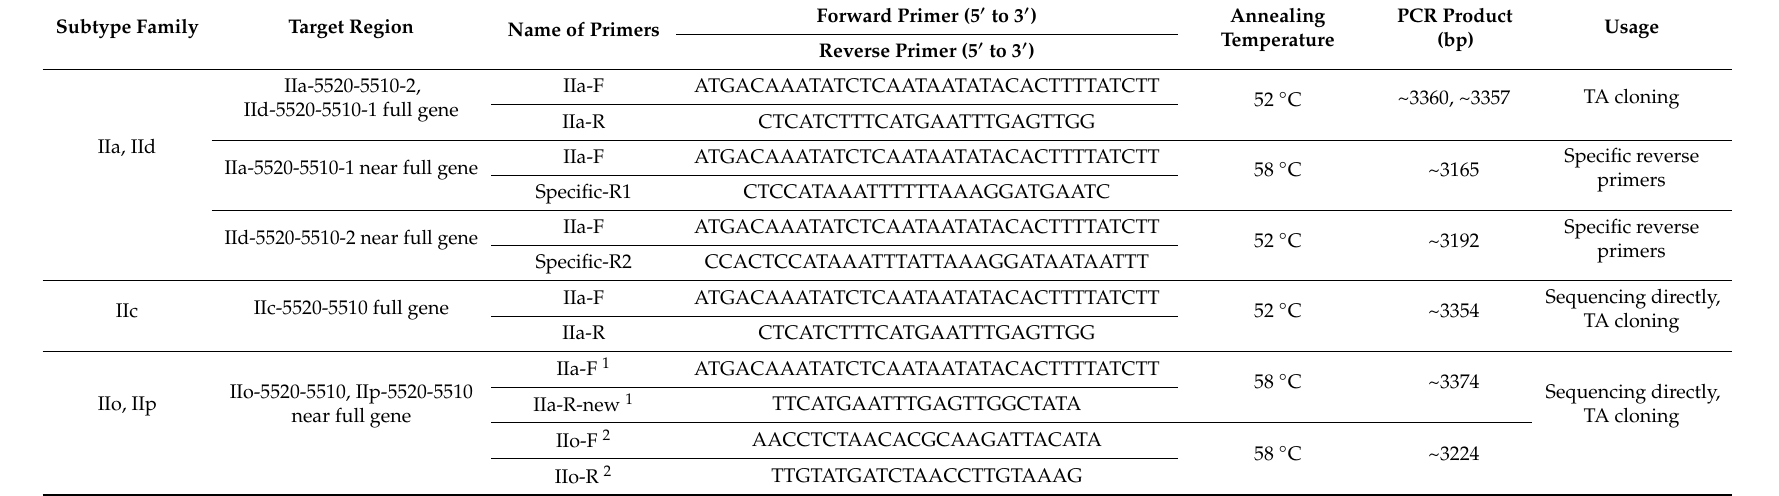
Table 2. Primers used to amplify near full sequences of the cgd6_5520-5510 gene in divergent Cryptosporidium parvum